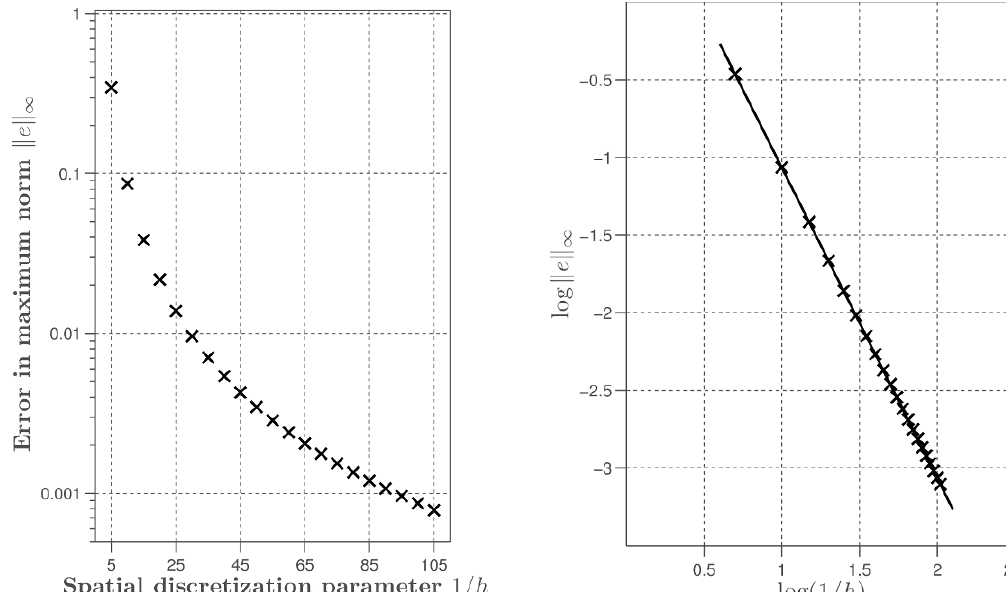
Figure 3. k·k ∞ norm error in the numerical solution for the test problem in subsection 4.3 vs. the spatial discretization parameter (left side). Log-log plot of the error vs. the spatial discretization parameter and a fitted line with slope − 2 (right